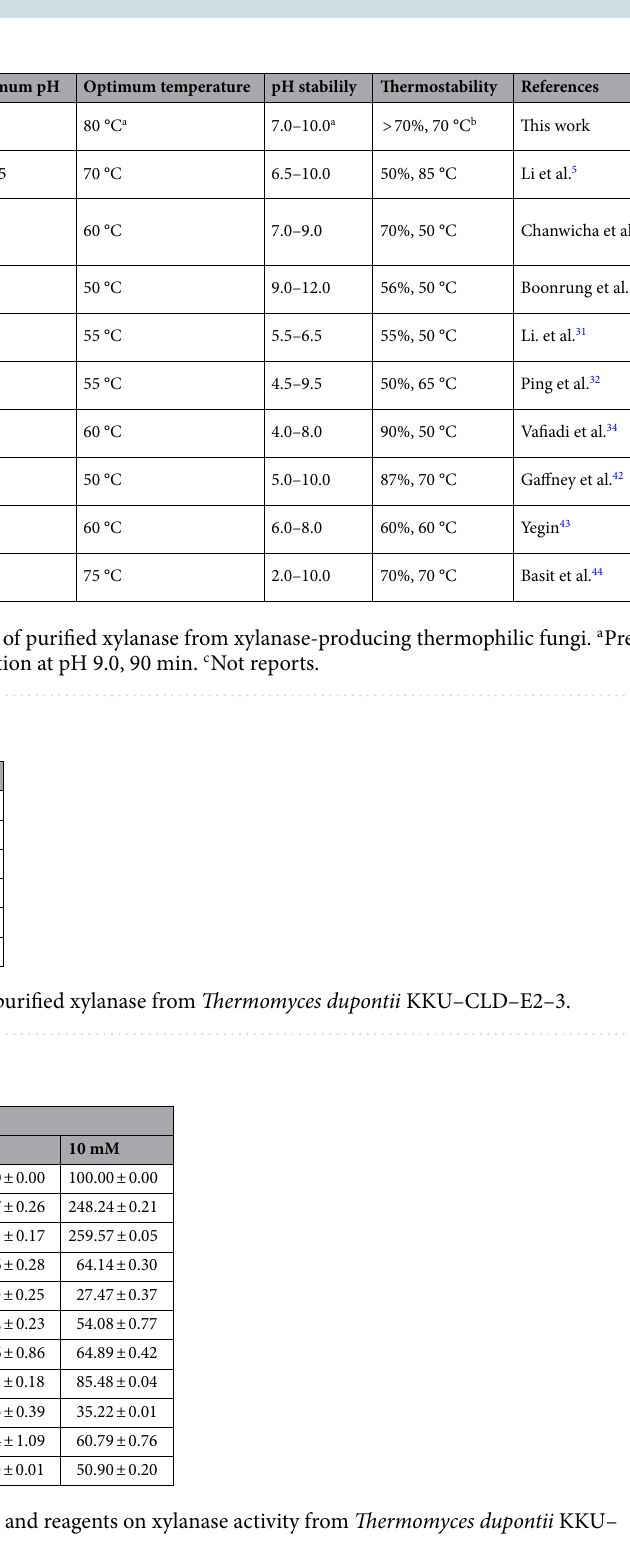
Table 6. Effect of different metal ion and reagents on xylanase activity from Thermomyces dupontii KKU– CLD–E2–3.